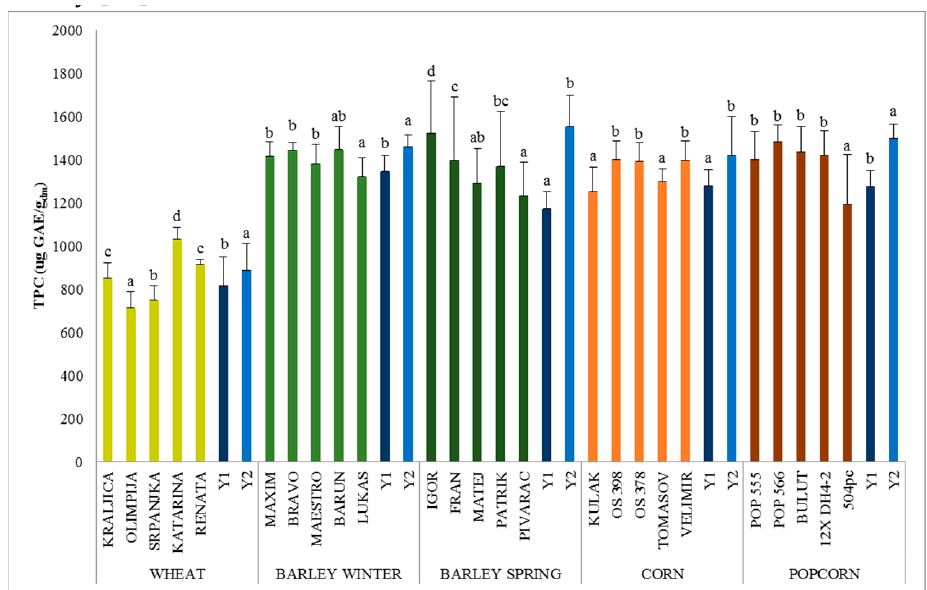
Figure 1. Total phenolic content ( μ g GAE/g dm ) in cereal grains. Mean ± SD of 2 years and triplicate extractions ( n = 6). Bars with different superscript (a-d) letters are significantly different ( p ≤ 0.05).